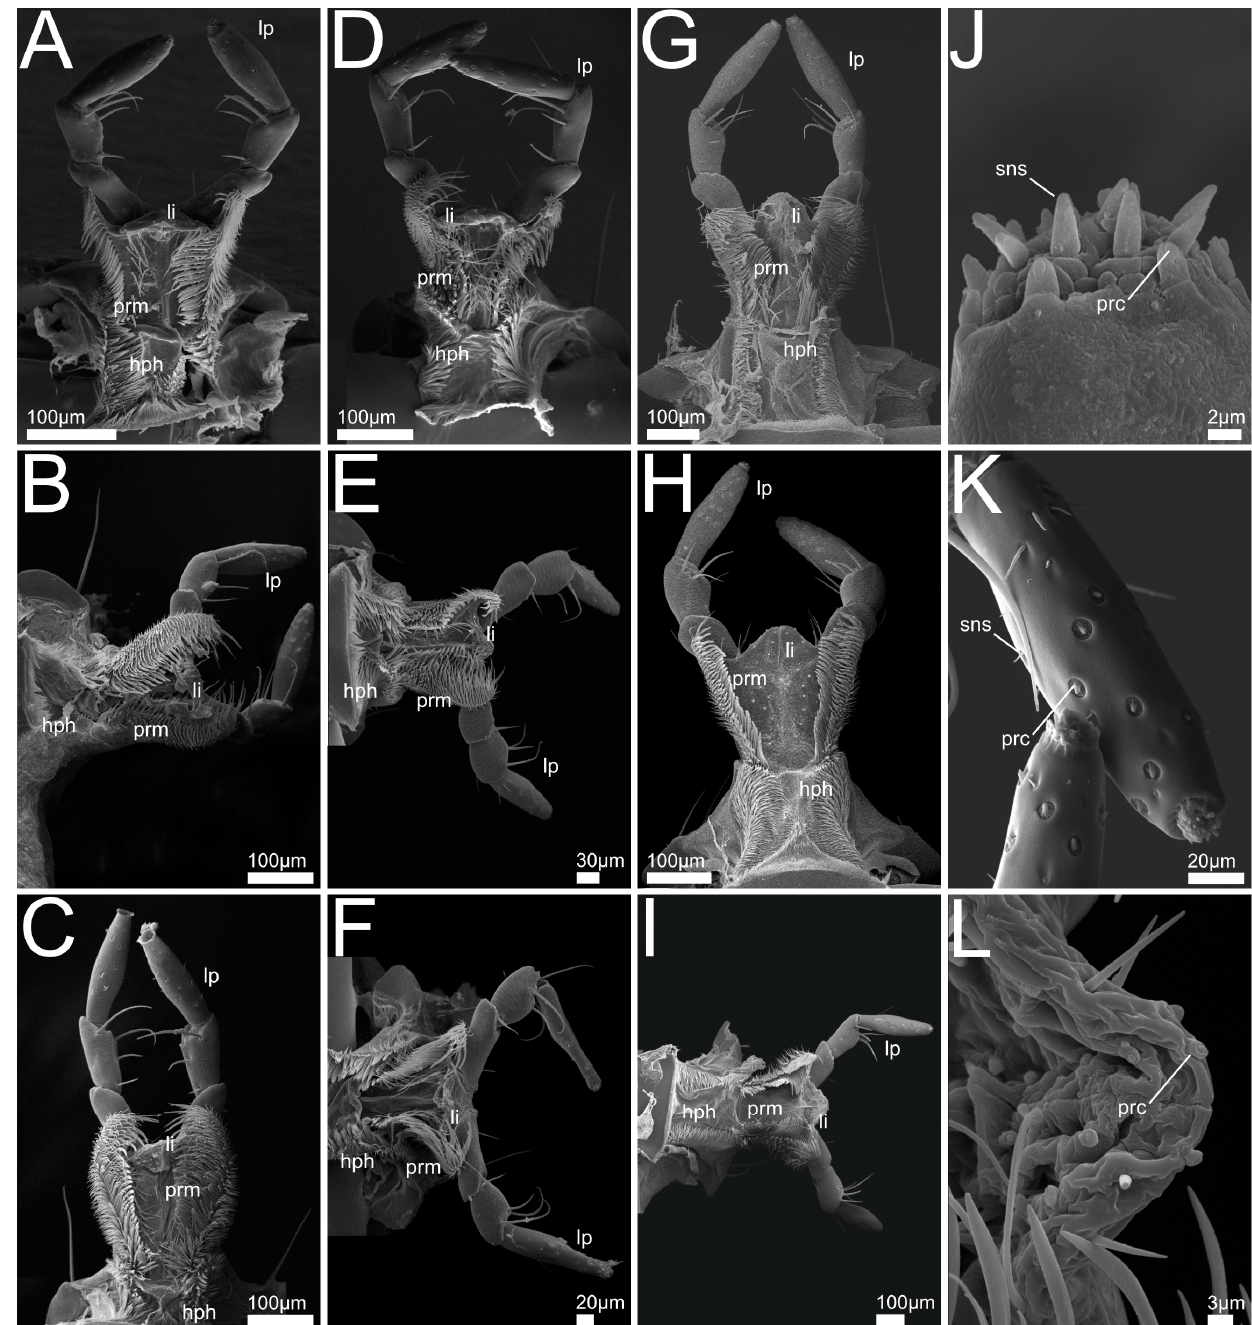
Figure 12. SEM views of Staphylinini labium-hypopharynx. Images A – I dorsal aspect of labium- hypopharynx, J–L with detailed views of receptors on apical palpomeres and ligula, ( A ) Bisnius sordidus ; ( B ) Philonthus varians ; ( C ) P. marginatus ; ( D ) P. rufipes ; ( E ) P. discoideus ; ( F ) P. alpinus ; ( G ) Quedius cinctus ; ( H ) Q. cruentus ; ( I ) Q. curtipennis ; ( J ) B. sordidus , apical receptor bundle; ( K ) P. rufipes , apical segments of labial palpi; ( L ) P. discoideus , dorsal aspect of anterior prementum and ligula. Abbreviations: hph: hypopharynx; li: ligula; lp: labial palp; prc: papilliform receptor; prm: prementum; sns: sensilla.